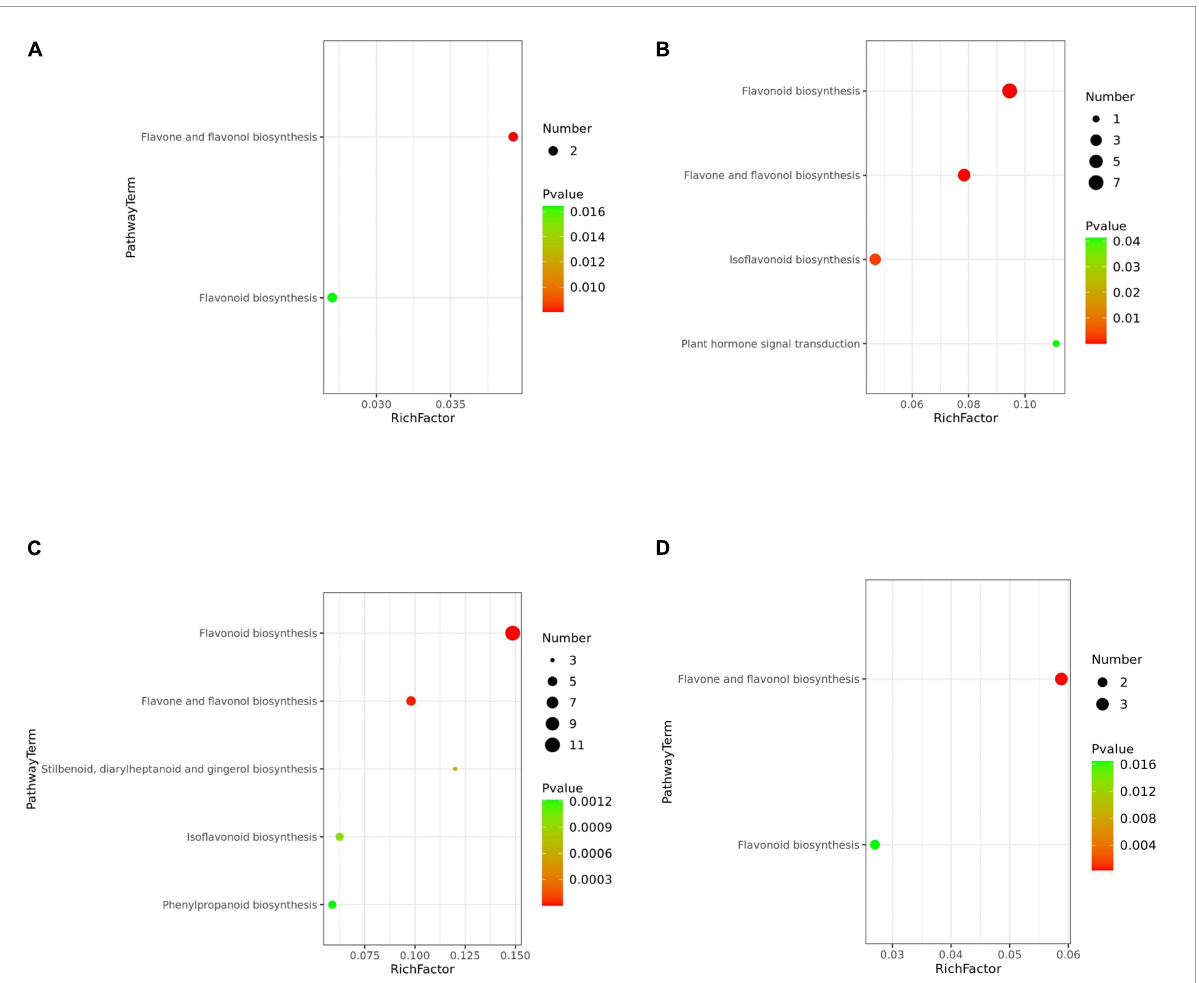
FIGURE6 Bubble plot of KEGG metabolic pathway enrichment analysis. (A) YH29 and WH10; (B) ZH12 and WH10; (C) WH10 and KNB; and (D) YH29 and ZH12. The p -value in the metabolic pathway is the significance of the enrichment of the metabolic pathway, and the significant enrichment pathway is selected for bubble plot. The ordinate is the name of metabolic pathway. The abscissa is the enrichment factor (rich factor means number of significantly different metabolites/number of total metabolites in the pathway). The larger the rich factor, the greater the enrichment degree. The color from red to green indicates that p -value decreases in turn. The larger the point, the more metabolites enriched on the pathway.